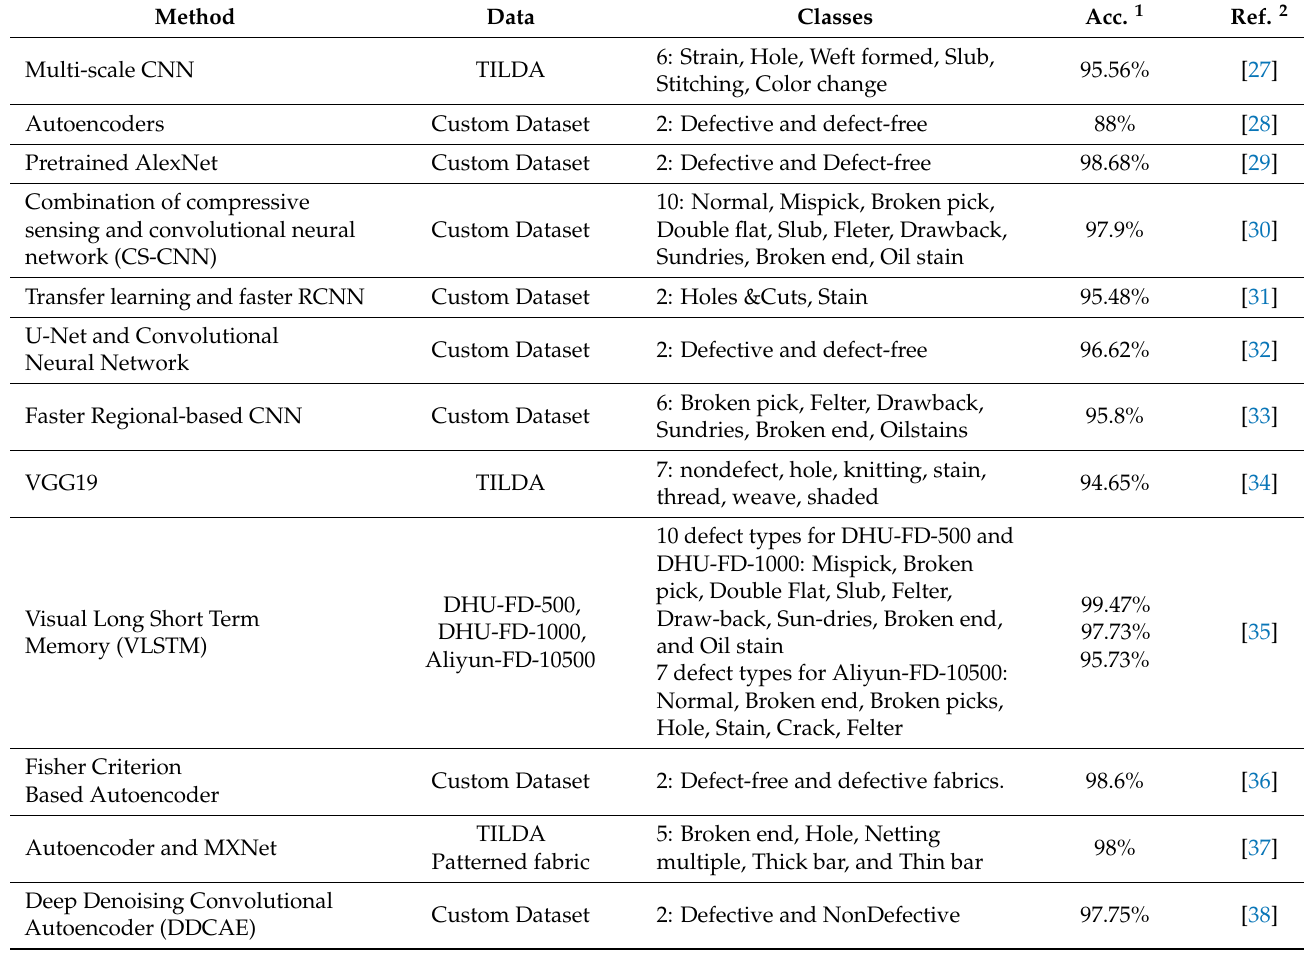
Table 1. Publication details for deep-learning based fabric defect detection